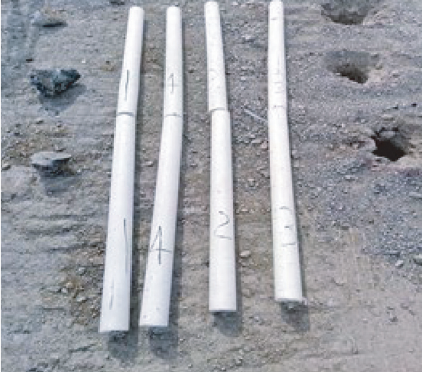
Figure 7: Gypsum rod before the blasting